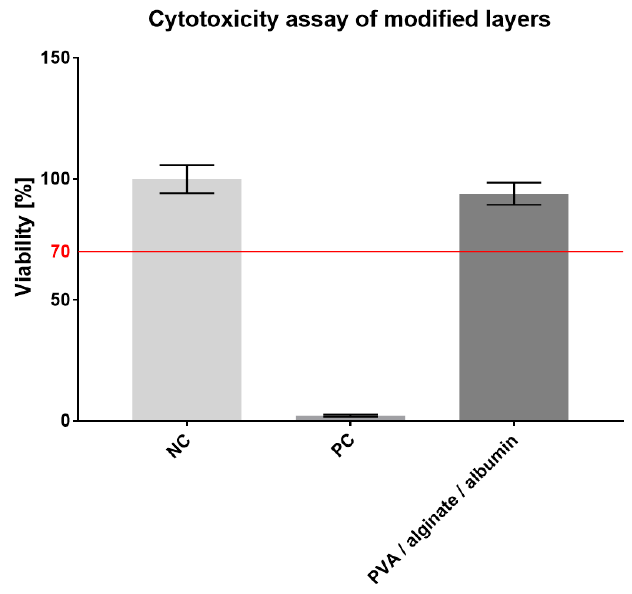
Figure 9. Cytotoxicity assay of the modified PVA/alginate/albumin fiber layer, 95% CI.